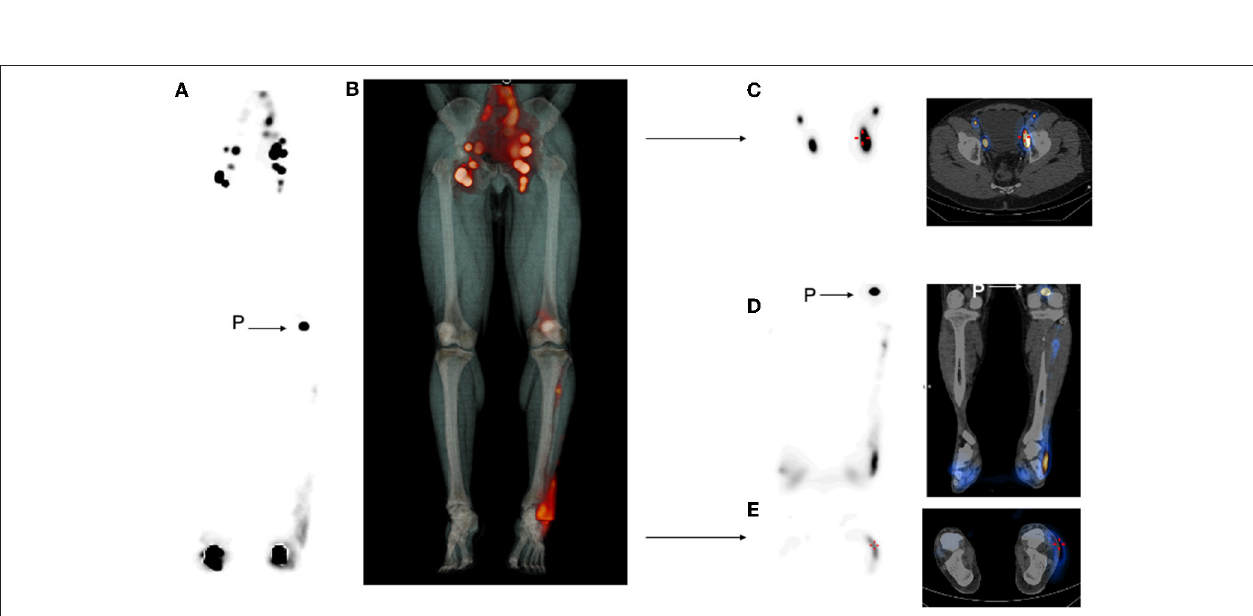
FIGURE 2 | 3D-ring cadmium -zinc-telluride single-photon emission CT (CZT SPECT) images. Maximum intensity projection (MIP) anterior view (SPECT only A , fused SPECT/CT B ). (C) Axial SPECT and SPECT/CT on the pelvic region. (D) Coronal SPECT and SPECT/CT on the leg. (E) Axial SPECT and SPECT/CT on the ankles. P with arrow shows the popliteal node. All SPECT images displayed are native non-corrected images.